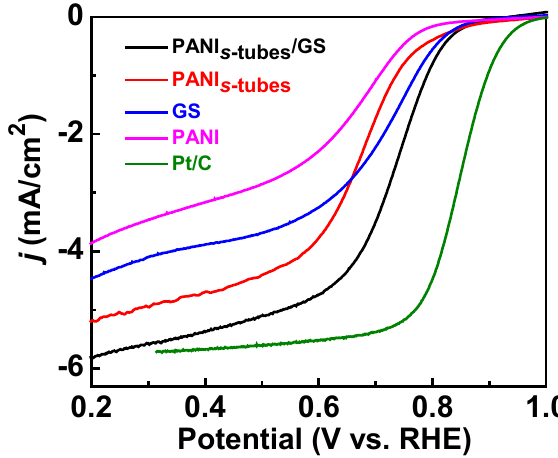
Figure 5. ORR polarization curves for different catalyst samples in O 2 -saturated 0.1 M